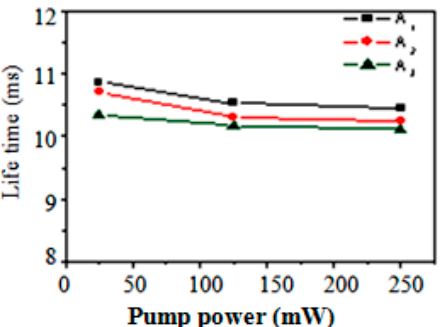
Figure 23. The effect of pump power on the lifetime of three EDFs (A1, A2, and A3). The optical gain spectra of these three EDFs in the C band region are shown in Figure 24. The gain differences of the phase-separated EDFs (A1 and A2) were within 1.2 dB, whereas that for fiber A3 was 1.70 dB.